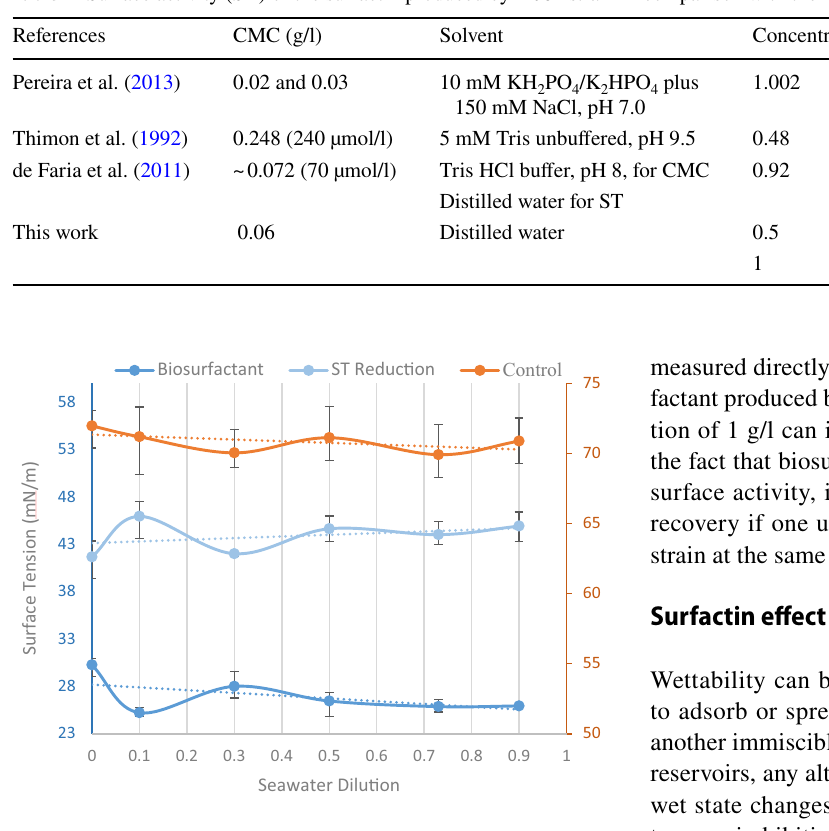
Fig. 4 Surface tension of different seawater dilutions with 0.6 g/l bio-